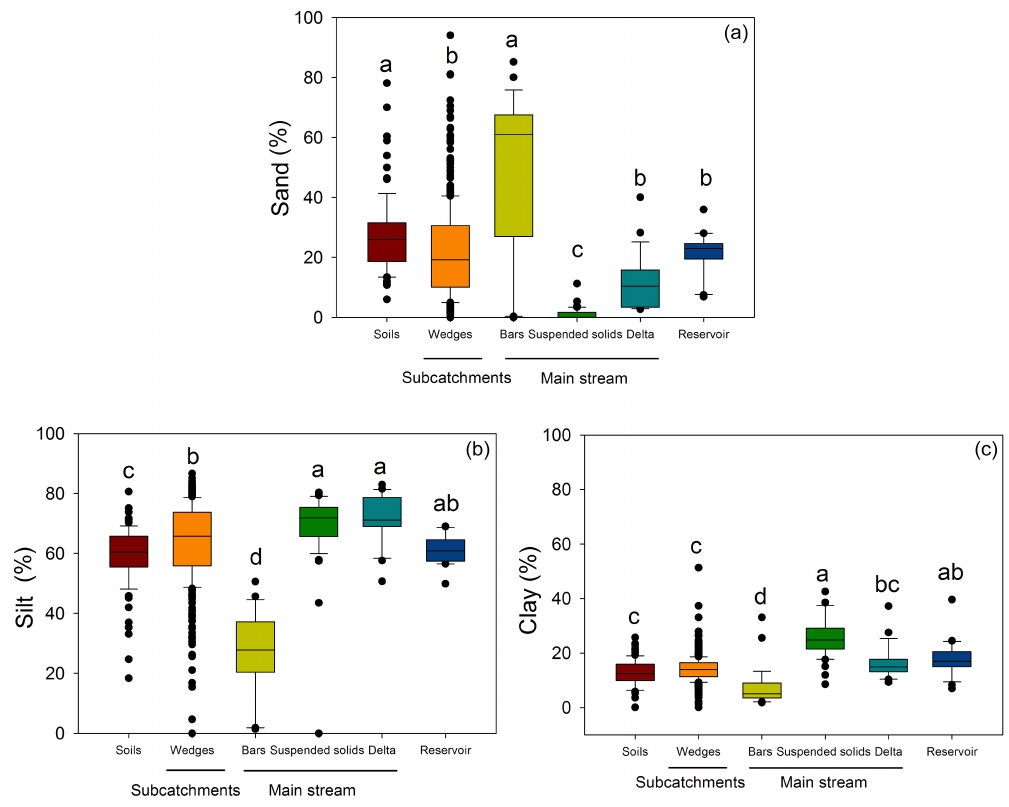
Figure 3. Median, percentiles (10th, 25th, 75th and 90th) and error of the main textural classes (A, sand; B, silt; C, clay) of the different types of sedimentary deposits within the Turrilla catchment. Different letters mean significant differences according to the Kruskal–Wallis test ( p <